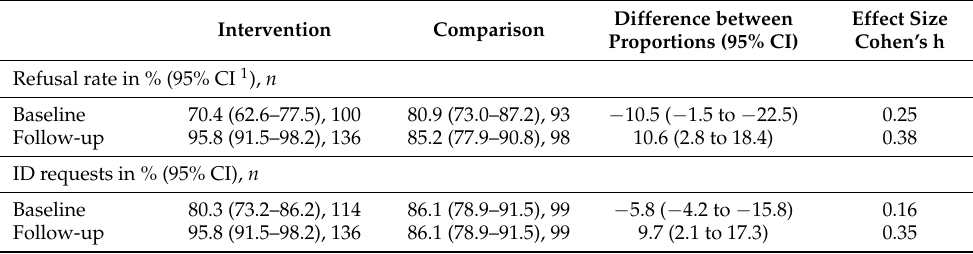
Table 2. Results from test purchases in the intervention ( n = 142) and comparison group ( n = 115). The intervention group contains municipalities where compliance checks had been conducted according to the protocol of the Public Health Authority of Sweden during the study period (as revealed by the process